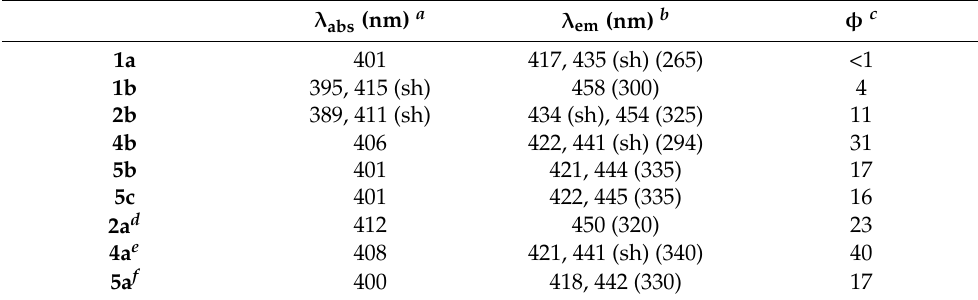
Figure 2. UV − vis absorption (solid line) and PL (broken line) spectra of ( a ) 1a and 1b in CH 2 Cl 2 (1.0 × 10 − 5 M) and ( b ) 2b , 4b , and 5b in CH 2 Cl 2 (1.0 × 10 − 5 M). The spectra of 5c are omitted since they are almost the same as those of 5b . Table 1. Photophysical properties of [7]helicene-like compounds and